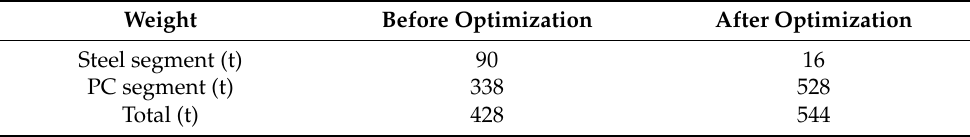
Table 10. Weight comparison of different tower.